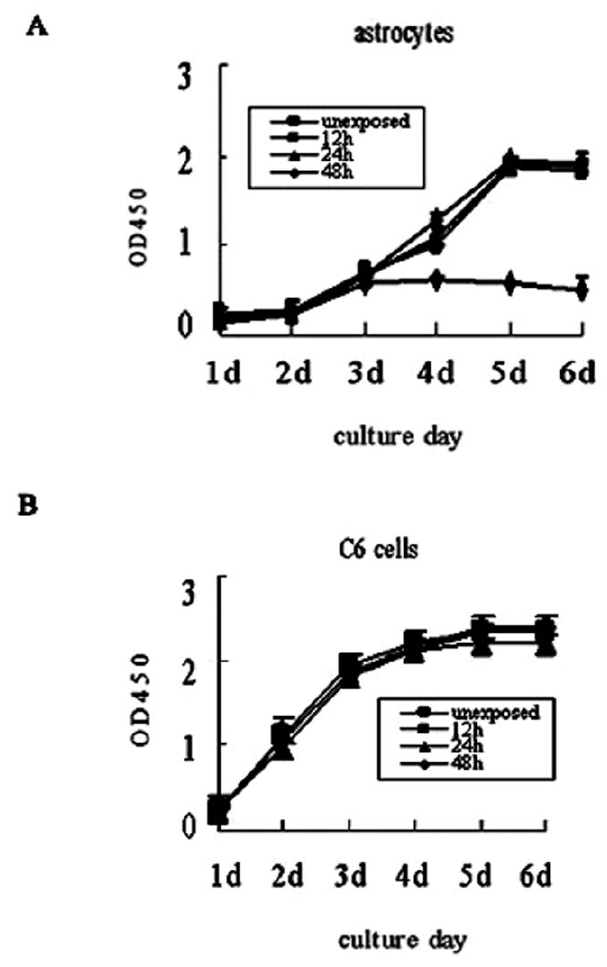
Figure 3. The growth of astrocytes was inhibited after 48 h exposure. (A)The proliferation of astrocytes after exposure (12 h, 24 h, or 48 h) was measured by CKK-8 assay from day 1 to 6. Exposure for 48 h significantly inhibited the growth of astrocyte. (B)No differences were observed in cell growth profile between unexposed and exposed C6 cells. The data represent the mean 6 SEM from three experiments.